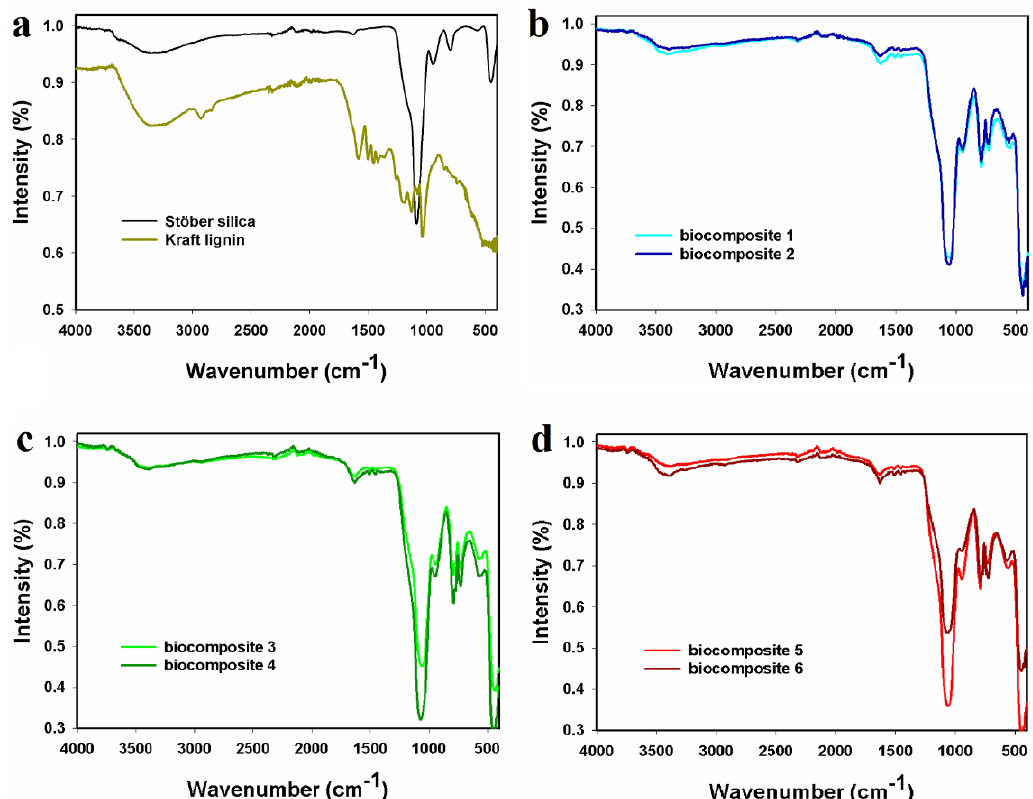
Figure 7. FT-IR spectra of (a) precursors of biocomposites, (b) SiO